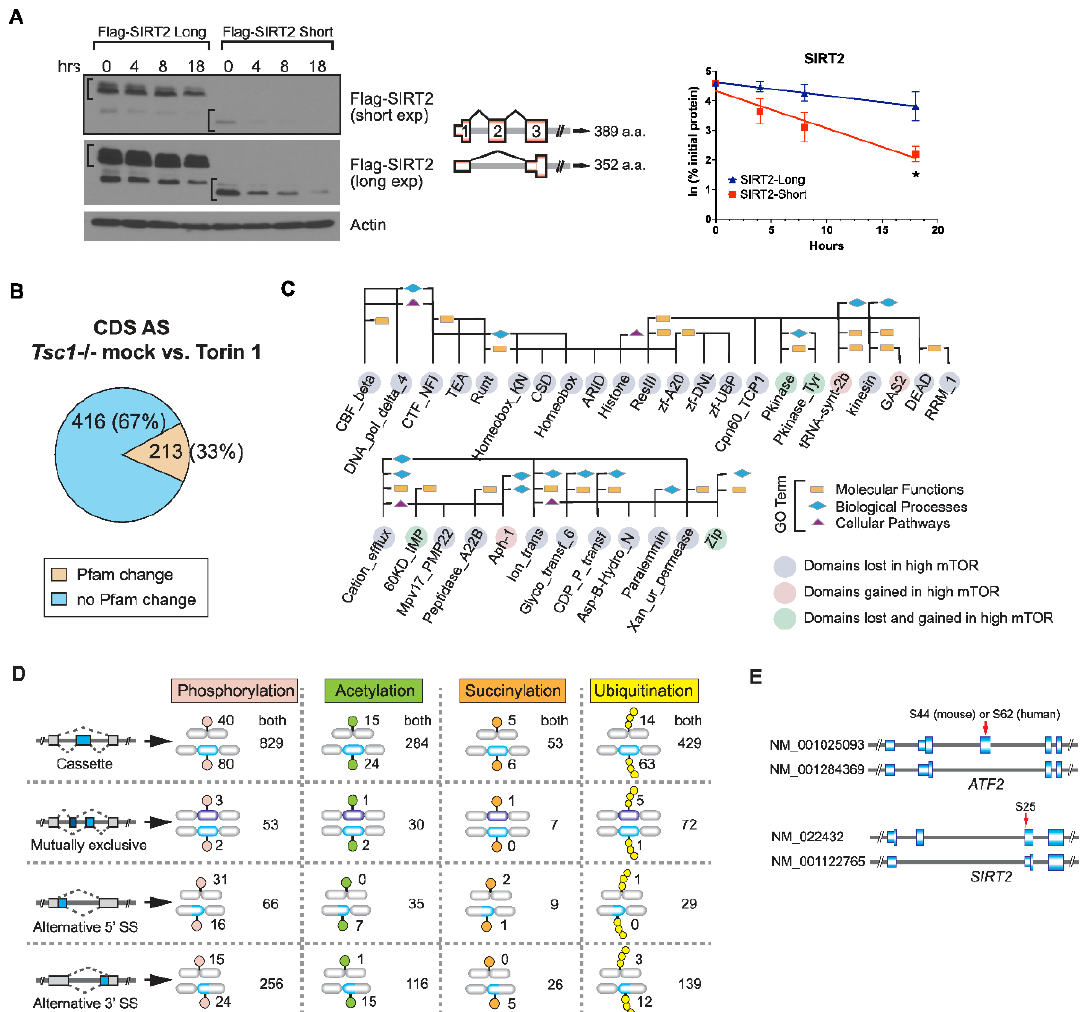
Figure 4. mTOR-driven exon skipping in CDS confers multifarious features in the proteome. ( A ) Analysis of protein isoform stability by Western blotting. Flag-tagged SIRT2 protein isoforms were transiently expressed in HEK293 and the difference in their stabilities was monitored in the presence of cycloheximide (30 ug/mL) for the indicated time points. Actin was used as a loading control. The protein level was quantified using densitometry in ImageStudioLite software and normalized to the actin level. Means (SD) from two technical repeats were subjected to two-tailed Student’s t -test for statistical analysis. p < 0.05 as significant (*). n.s. denotes no significance. ( B ) Proportion of mTOR-regulated AS from the coding region showed a Pfam domain change. ( C ) Examples of analysis of the functional Pfam domains disrupted or gained by AS events in the CDS of